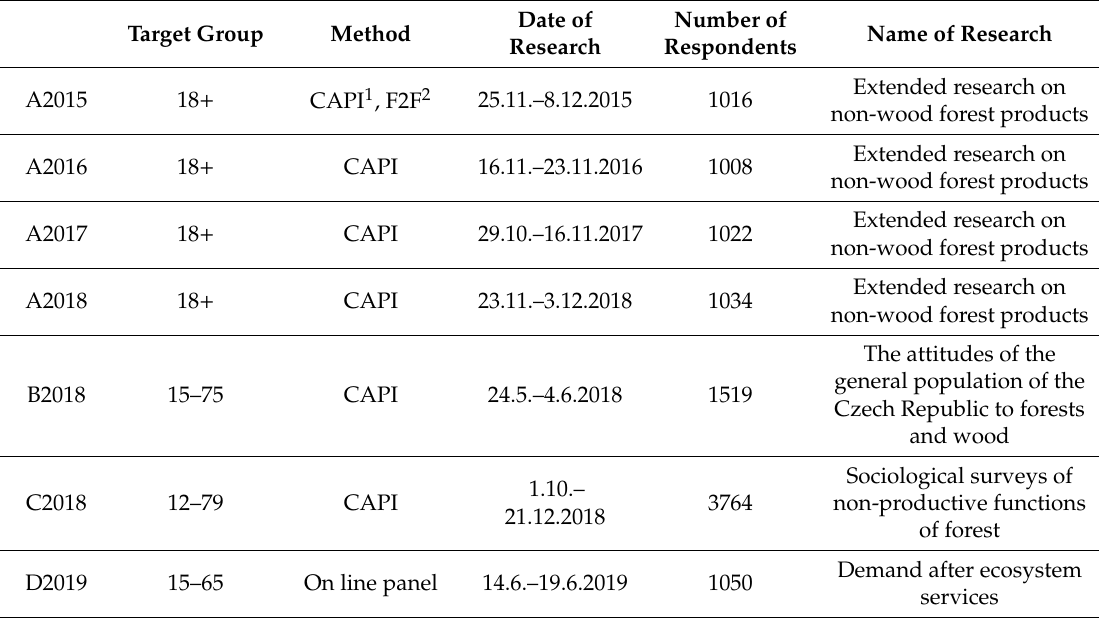
Table 1. The list of the research studies whose data are analysed and discussed in the following